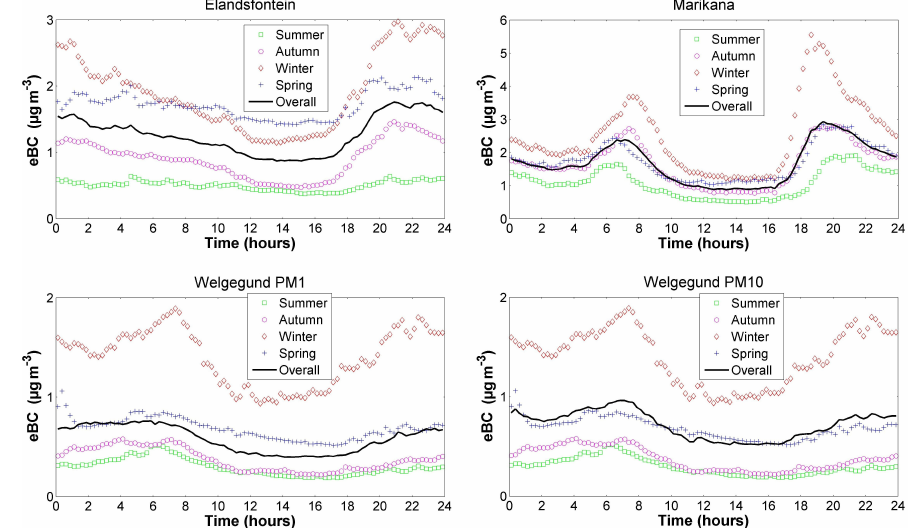
Figure 6. Overall (all the data) and seasonal (each season separately) average eBC diurnal patterns observed for Elandsfontein, Welgegund and Marikana. Summer: DJF, Autumn: MAM, Winter: JJA and Spring: